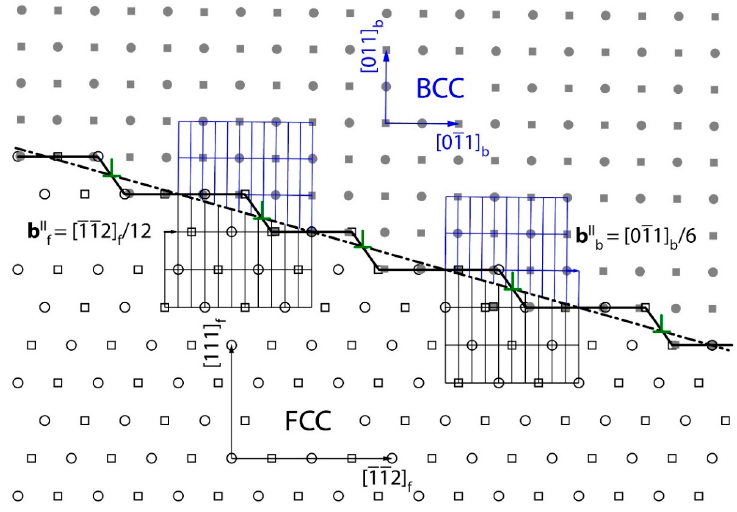
Figure 7. The secondary misfit dislocations ‘ ⊥ ’ at each step/disconnection. Two Burgers circuits are drawn in the CDSCL to identify the associated Burgers vectors expressed in the FCC and BCC lattices. The circle and square patterns have the same meaning as those in Figure